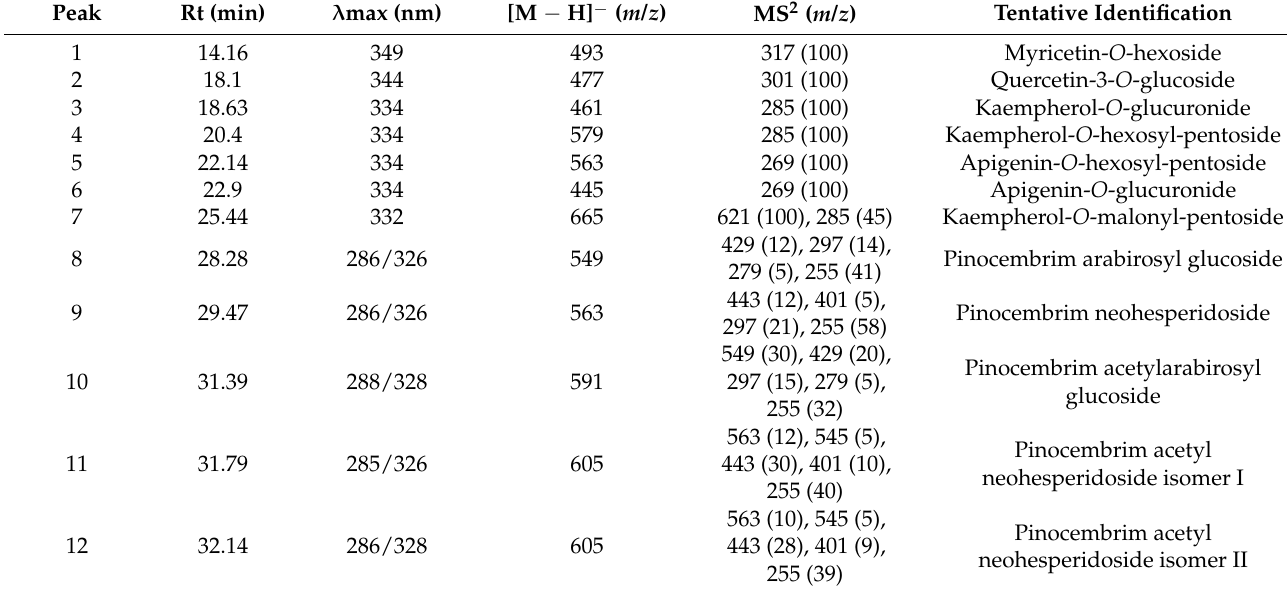
Table 3. Retention time (Rt), wavelengths of maximum absorption in the visible region ( λ max), mass spectral data, and tentative identification of the phenolic compounds present in the extracts of Centaurea raphanina spp. mixta plants.